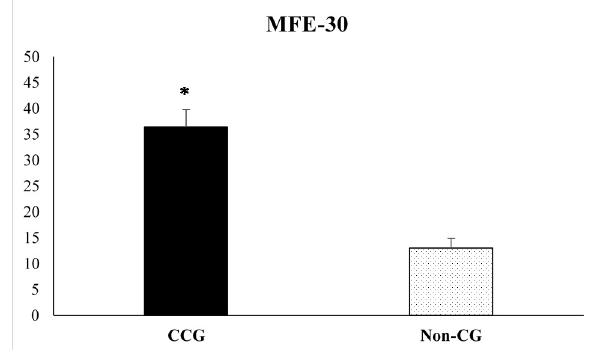
Figure 1. Scores obtained on the Memory Failures of Everyday scale (MFE-30) by the informal cancer caregiver’s group (CCG) and the non-caregivers control group (Non-CG). Data are presented as mean ± SEM. (*) p < 0.0001, CCG vs. Non-CG.